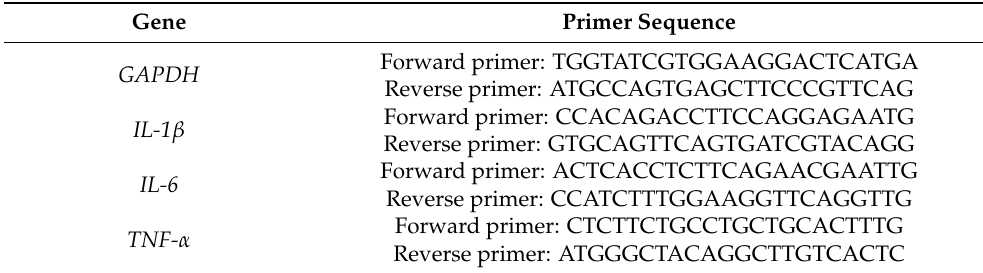
Table 2. Primer sequences used for pro-inflammatory gene expression.